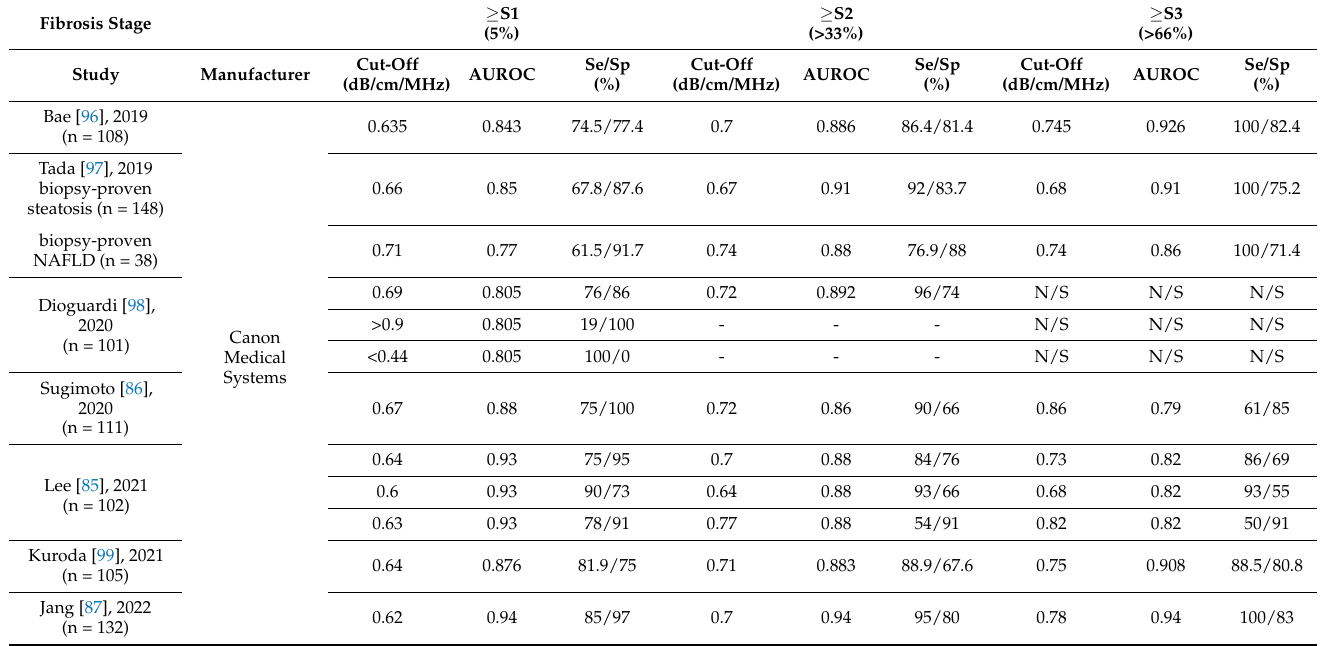
Table 2. Performance of ATI/UGAP cut-off values by 2D-SWE for detecting different grades of liver steatosis in biopsy-proven